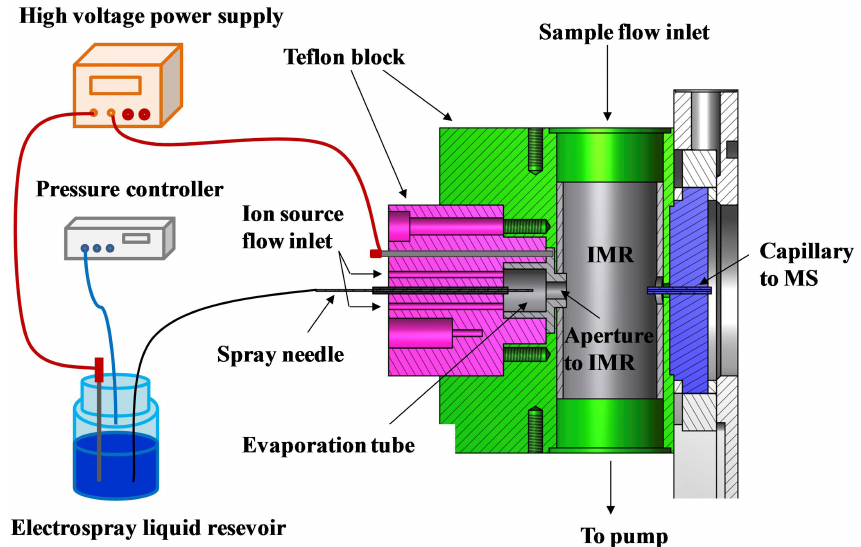
Figure 1. Schematic of the electrospray chemical ionization (ESCI) source module. Also shown are the orthogonal atmospheric pressure IMR and the entrance capillary serving as the atmospheric pressure interface between the IMR and the vacuum chamber of HR-ToF-MS. See text for detailed description of the